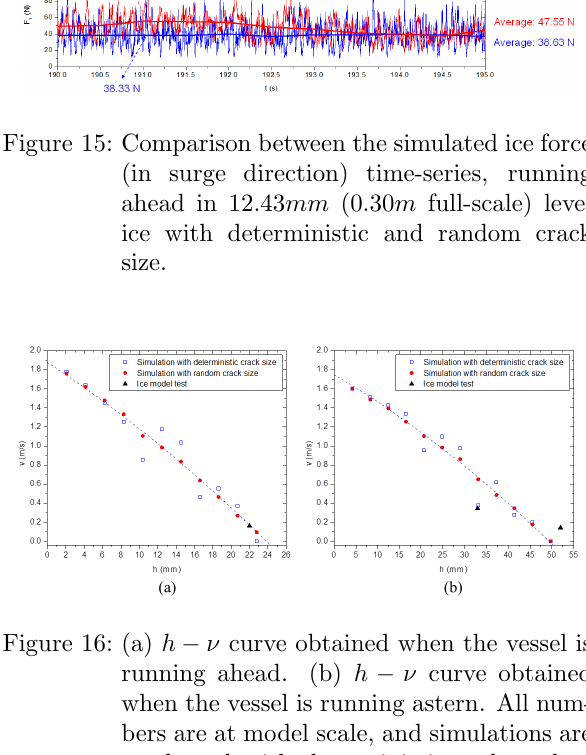
Figure 14: Examples of the simulated icebreaking runs with random crack size. (a) Running ahead in 10 . 36 mm (0 . 25 m full-scale) level ice. (b) Running ahead in 12 . 43 mm (0 . 30 m full- scale) level ice.